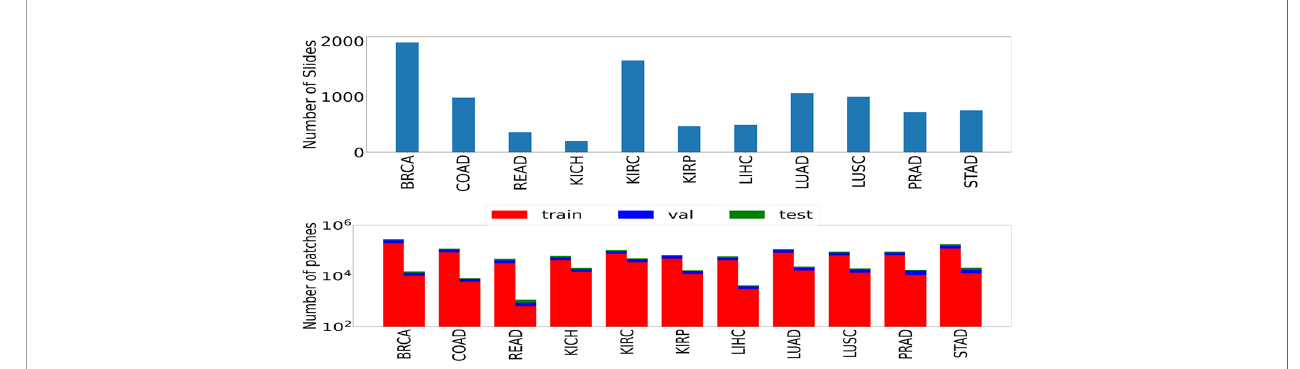
FIGURE 1 | The number of slides (top) and patches (bottom) used in the study. Numbers of patches belonging to both classes (left bar represents cancer samples and right bar represents normal samples) are shown in the form of two rectangular bar